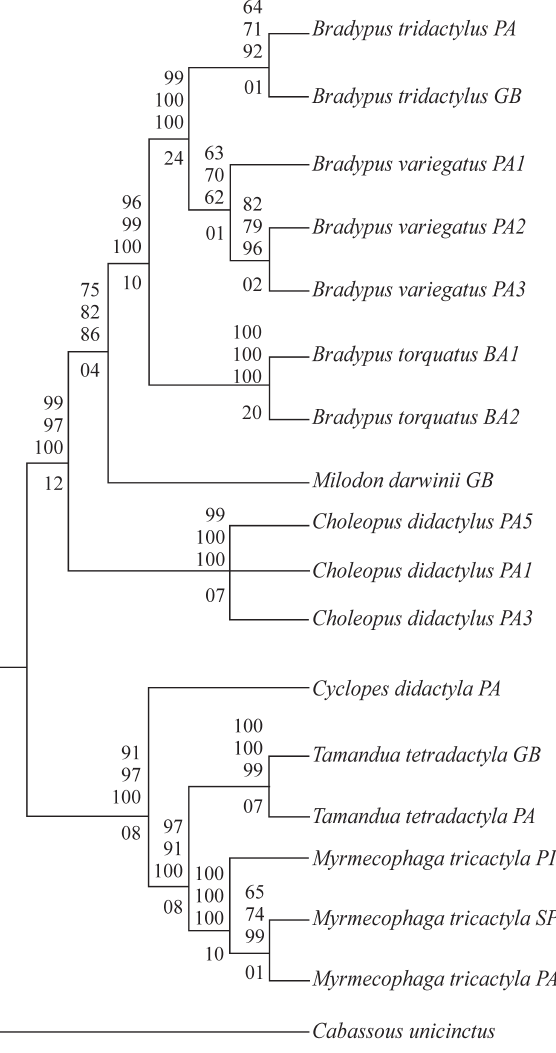
Figure 1 - Maximum likelihood phylogenetic tree obtained using a partial fragmentofmitochondrial16SrRNA.Theevolutionarymodelselectedby Modeltest was the K2P model, equal nucleotide frequencies, transi- tion-transversion ratio of 3.1585 and a gamma distribution of shape α = 0.3103 with zero of invariable sites modeling the site variation. Numbers above the branches indicates the maximum likelihood (1000 bootstrap replications), maximum parsimony bootstraps (1000 replications), and Bayesian posteriori probabilities, respectively. Numbers below branches show Bremer Decay indexes. For Bayesian inference (BI) we performed 10 6 generations running four independent markovian chains with the evo- lutionary model chosen by Modeltest. Maximum-likelihood (ML), maxi- mum parsimony (MP), minimum evolution (ME) and Bayesian analysis produced the same topology, with ME analysis showing Mylodon group- ing with